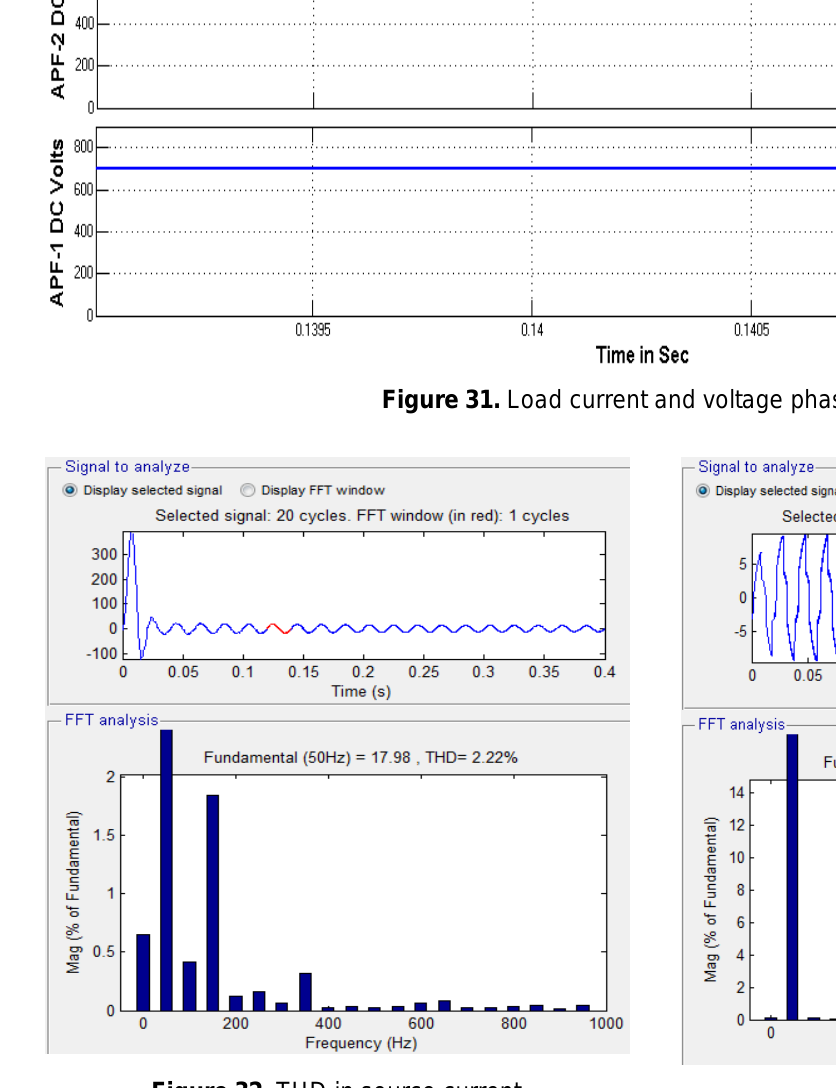
Figure 32. THD in source current